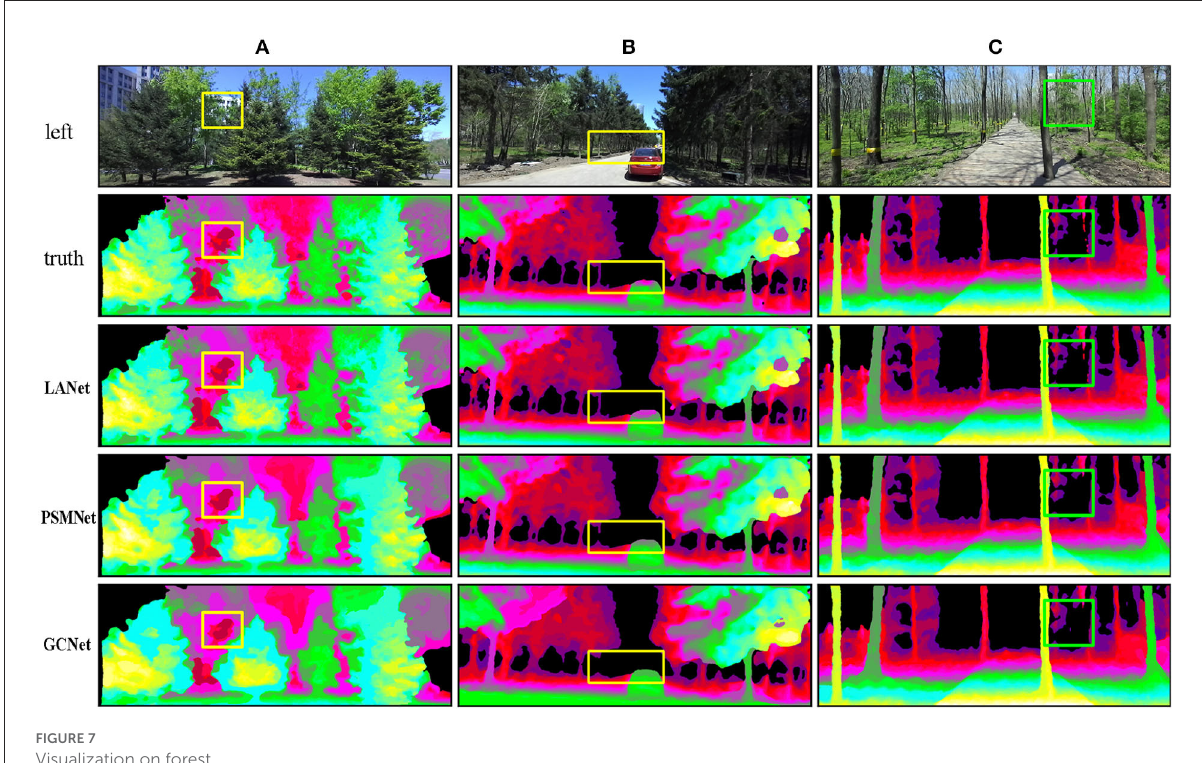
FIGURE7 Visualization on